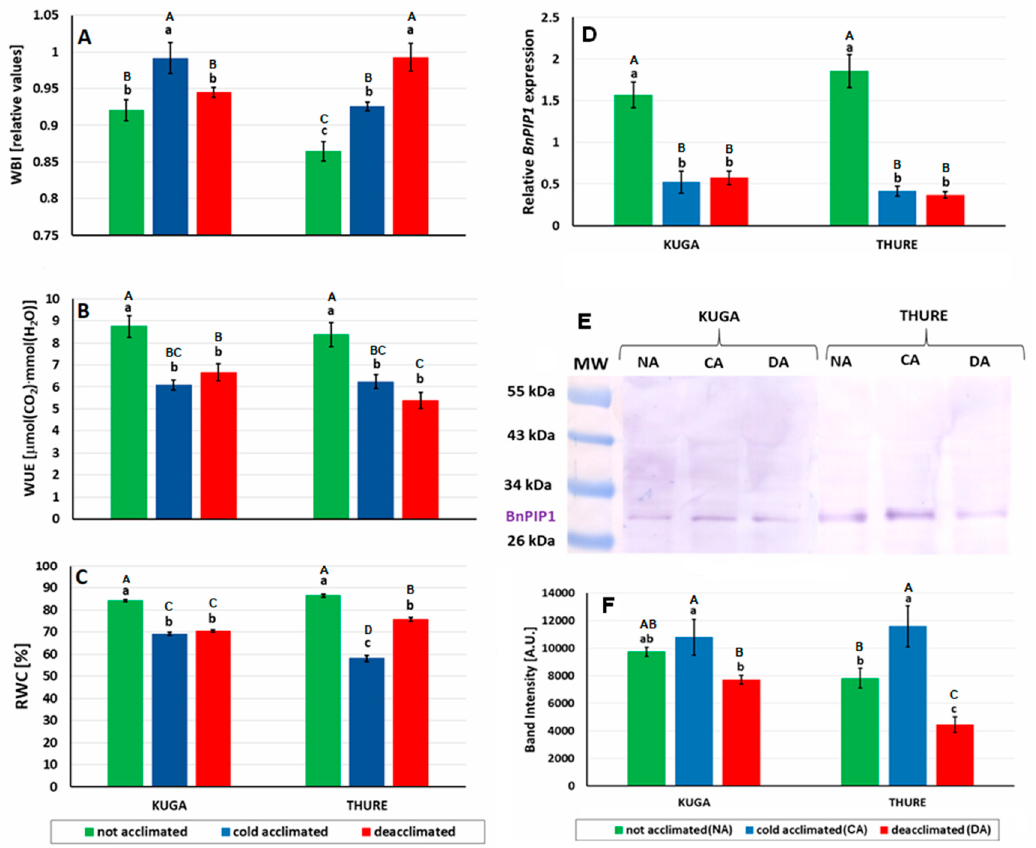
Figure 6. Water relations of leaves of not acclimated, cold-acclimated, and deacclimated oilseed rape cv. Kuga and cv. Thure; ( A ) Water band index (WBI) based on the leaf reflectance at 970 nm, ( B ) water use e ffi ciency index (WUE) based on the quotient of photosynthetic rate and transpiration (P N / E), ( C ) leaf relative water content (RWC) calculated as (fresh mass—dry mass) / (turgid mass—dry mass)] × 100. Values marked with the same letters do not di ff er significantly at p ≤ 0.05 according to Duncan’s test, n = 10; lowercase—comparison separately within each cultivar, uppercase—comparison between cultivars. Accumulation of the aquaporin transcript BnPIP1 ( D ) and the protein BnPIP1 ( E , F ) in the leaves of the not acclimated, cold-acclimated, and deacclimated oilseed rape cv. Kuga and cv. Thure. The results of the accumulation of the transcript ( D ) are presented as the fold change in the expression of the BnPIP1 gene in the given samples compared to the endogenous reference gene Actin . The visualised bands ( E ) corresponding to the BnPIP1 protein were identified using the anti-BnPIP1 antibody. The picture shows two individual gels made separately—first for cv. Kuga, second for cv. Thure. In total, 40 µ g of proteins were loaded onto the gel. MW—molecular weight standard (Thermo Scientific PageRuler Prestained Protein Ladder). A.U.—arbitrary units. Values marked with the same letters do not di ff er significantly at p ≤ 0.05 according to Duncan’s test, n = 5 (transcript), n = 6 (protein); lowercase—comparison separately within each cultivar, uppercase—comparison between cultivars.